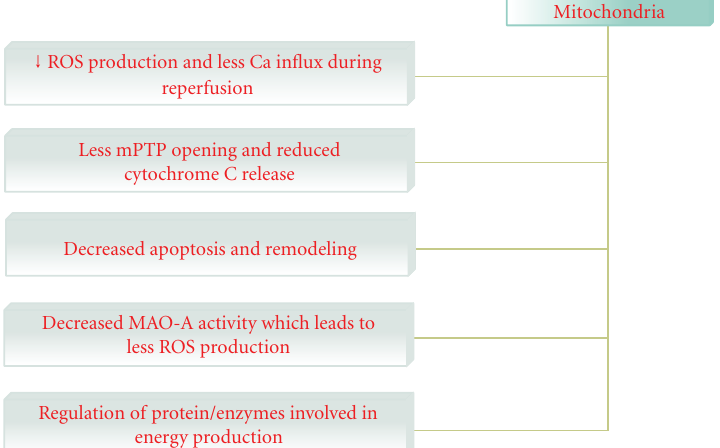
Figure 4: selected exercise-induced mitochondrial change in cardiac muscles. (Mitochondrial permeability transition pore, mPTP).